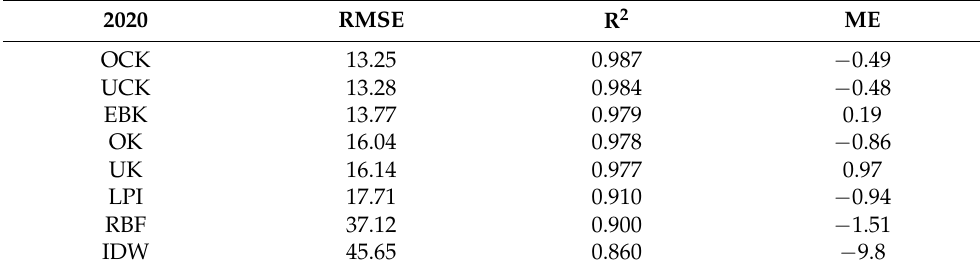
Figure 7. ( a ) Correlation between the groundwater level and the topographic elevation. ( b ) Correlation between measured and predicted groundwater levels for 2020. Table 2. Comparison between optimal models of spatial